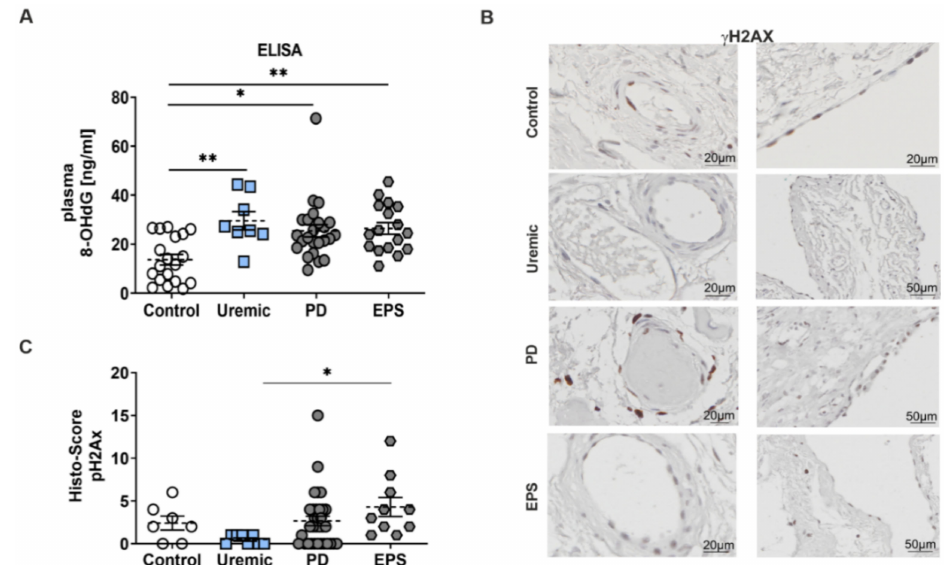
Figure 3. Enhanced oxidative DNA-damage in plasma and the peritoneal membrane of PD patients. ( A ) 8-OHdG content was analyzed by ELISA using plasma samples (mean ± S.E.M.; *: p < 0.05; **: p < 0.01; control: n = 19, uremic: n = 8, PD: n = 24 and EPS: n = 17). ( B ) Representative peritoneal sections showing vessels (first row) and mesothelium (second row) stained for γ H2AX. ( C ) Scatter blots show the Histo-Score of the sections (mean ± S.E.M.; *: p < 0.05; control: n = 7, uremic: n = 8, PD: n = 33 and EPS: n =